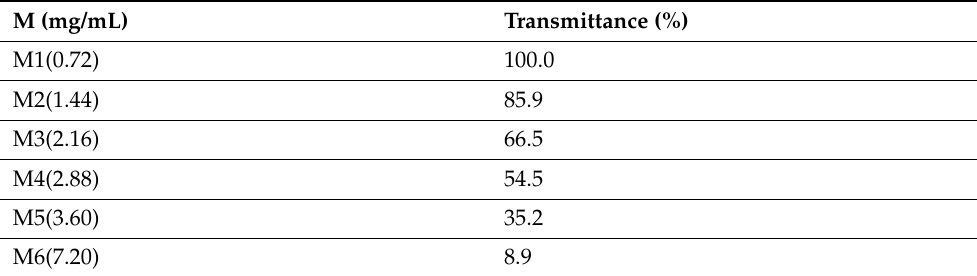
Table 1. The light transmittance at different concentrations of